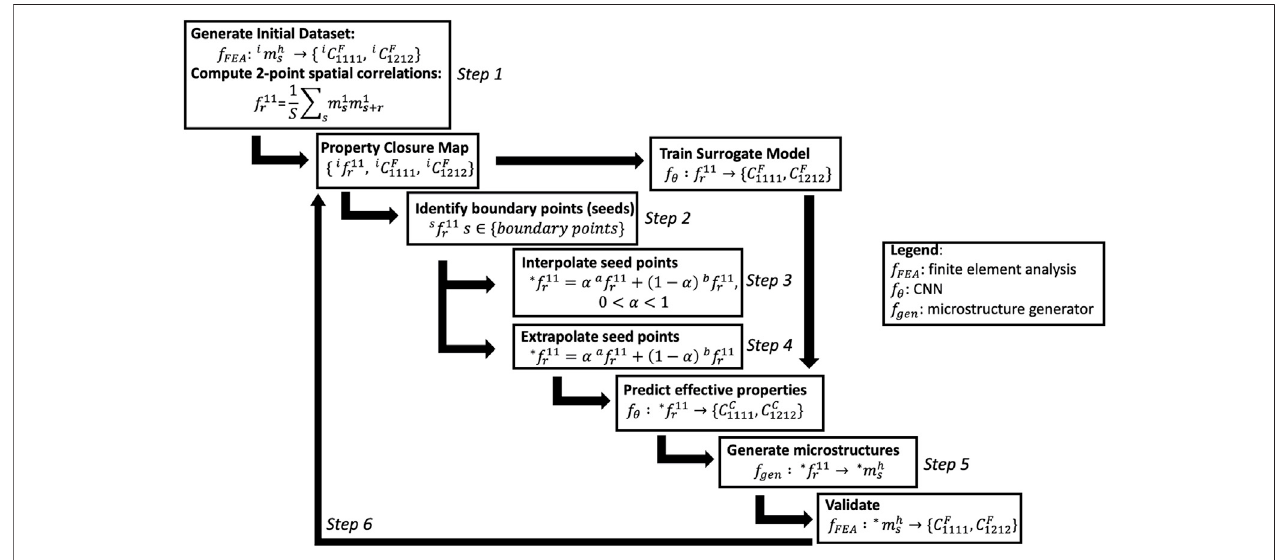
FIGURE 3 | A fl ow chart of the proposed